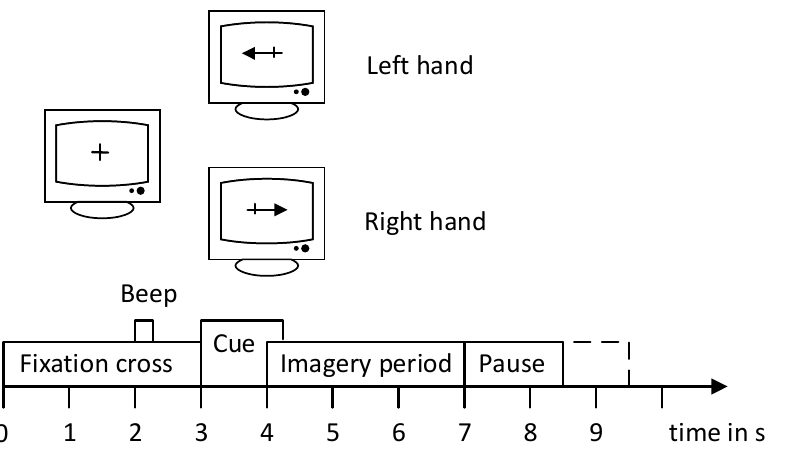
Figure 1. The paradigm of BCI competition IV 2b.